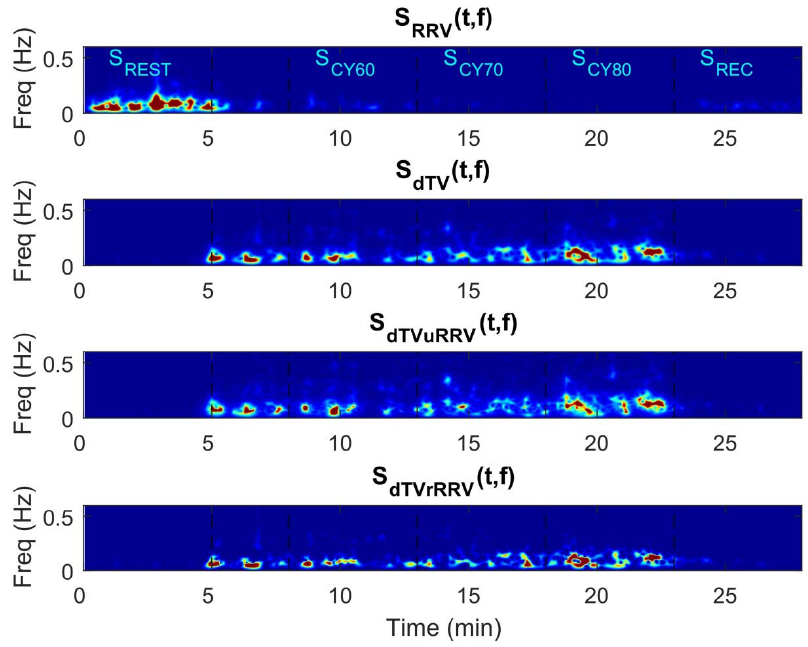
Figure 4. Example of the time-frequency distribution for RR variability (RRV), dT variability (dTV), dTV unrelated to RRV (P dTVuRRV ) and dTV related to RRV (P dTVrRRV ) obtained for the same subject as in Figure 2. Dotted lines separate the different test segments: resting (S REST ), cycling (S CY ) and recovery (S REC ). S CY was divided into three stages corresponding to 60, 70 and 80% of estimated HR max , denoted as S CY60 , S CY70 and S CY80 , respectively.